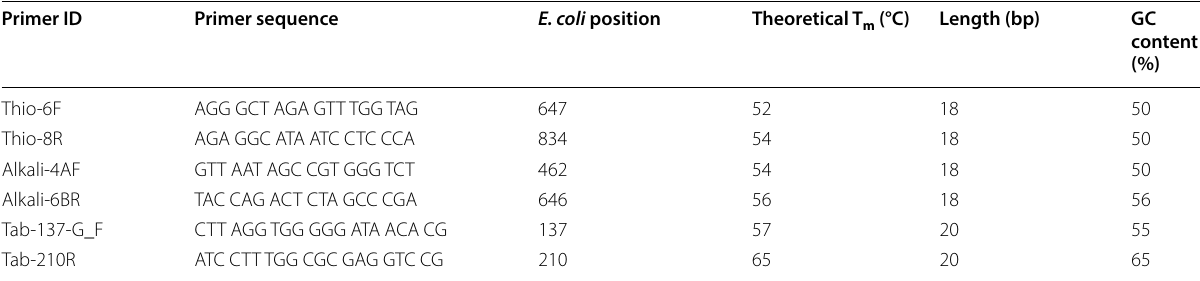
Table 2 Description of designed species-specific primers description